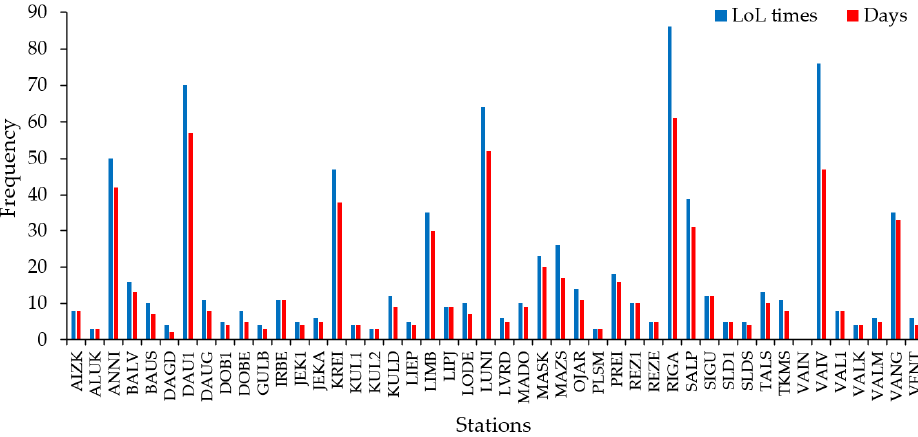
Figure 12. Frequency of Loss-of-Lock in CORS stations.